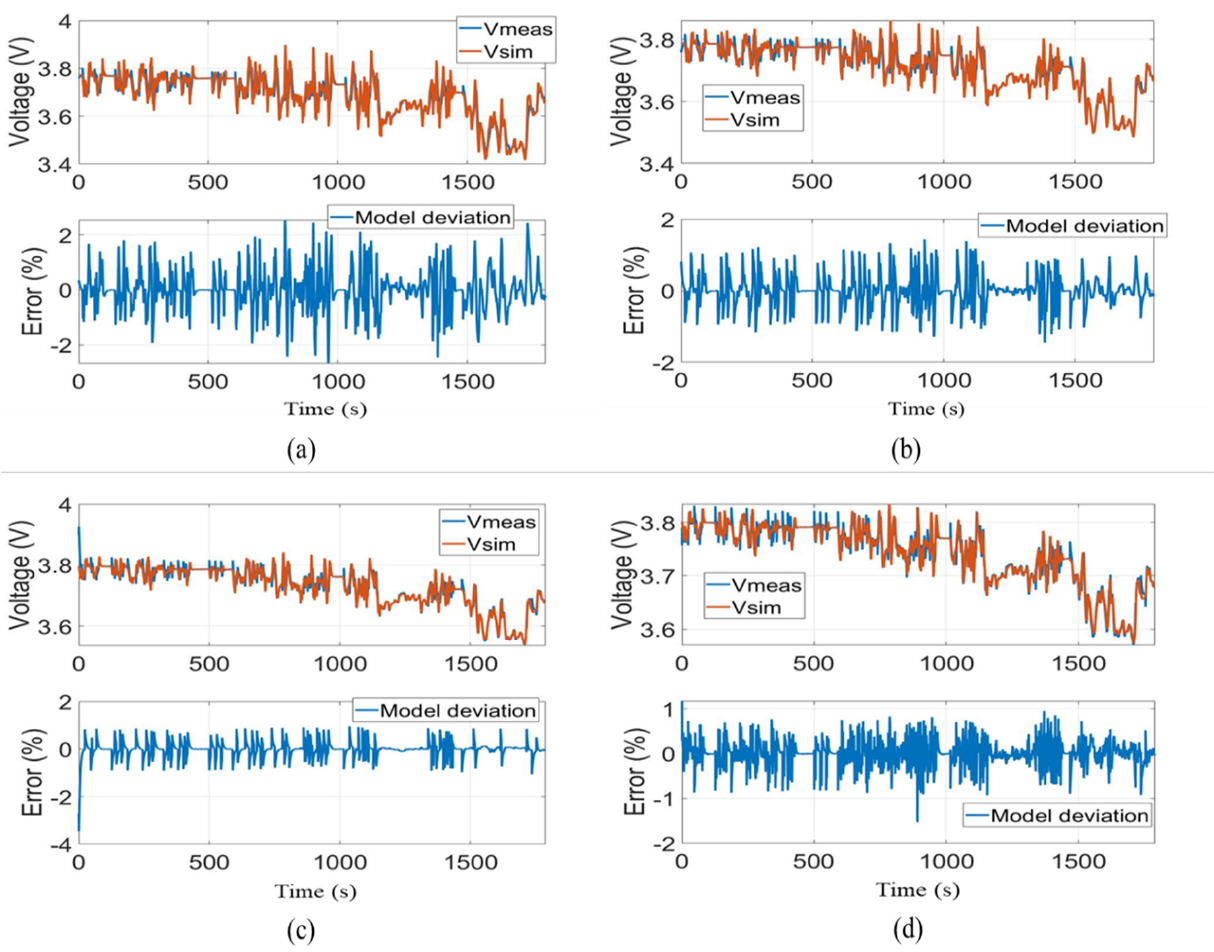
Figure 10. Validation of the DP_ECM at 0 °C ( a ), 10 °C ( b ), 25 °C ( c ), and 45 °C ( d ).